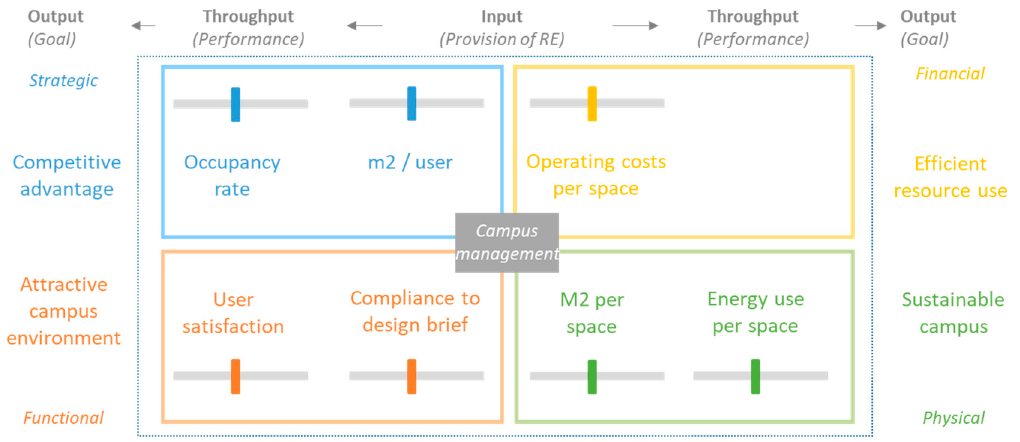
Figure 1. Conceptual design for the structure of the dashboards, based on previous research (see also Section 3).